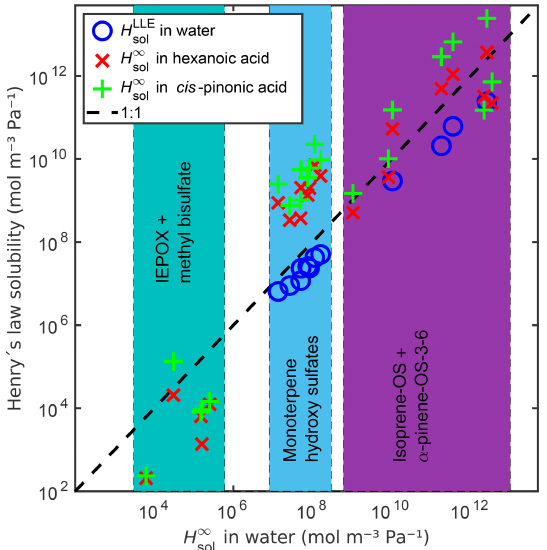
Figure 8. Comparison between infinite dilution Henry’s law solu- bility ( H ∞ ) in water, hexanoic acid and cis -pinonic acid, and LLE sol based Henry’s law solubility ( H LLE ) in water. The dashed line sol shows the 1 : 1 ratio between H ∞ in water and the other Henry’s sol law